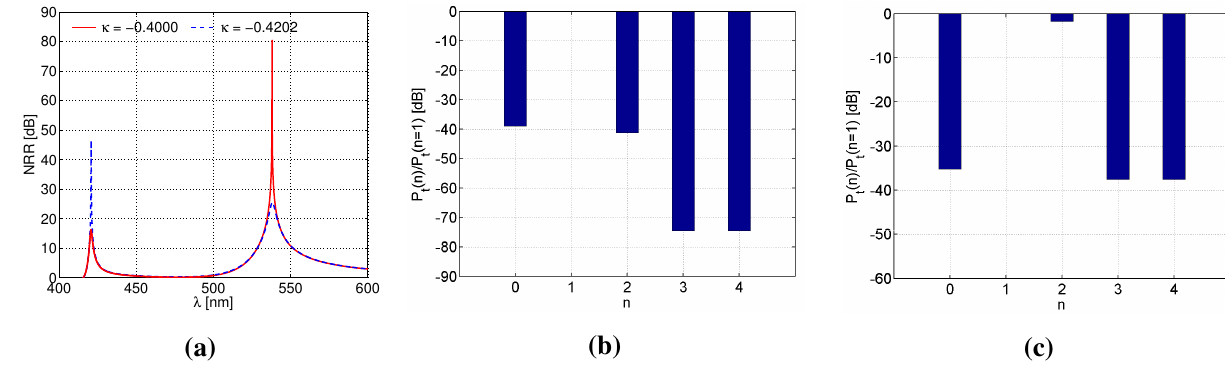
Figure 5. ( a ) The NRR as a function of the excitation wavelength λ for the eccentric 3L NPs = − 5 nm), which optimize the NRR at the two resonances of interest (around 539 nm ( x 13 and 421 nm). The corresponding total power spectrum of the n -th mode, i.e. , the total power in the n = 0 , 1 , 2 , 3 and 4 modes, normalized by the the total power in the dipole ( n = 1 ) in the gain-optimized eccentric 3L NPs. ( b ) κ = − 0 . 4000 , 538 . 7 nm; ( c ) κ = − 0 . 4202 , 420 . 7 nm. The core is displaced by an amount of x = − 5 nm. Refer to the main text for 13 more